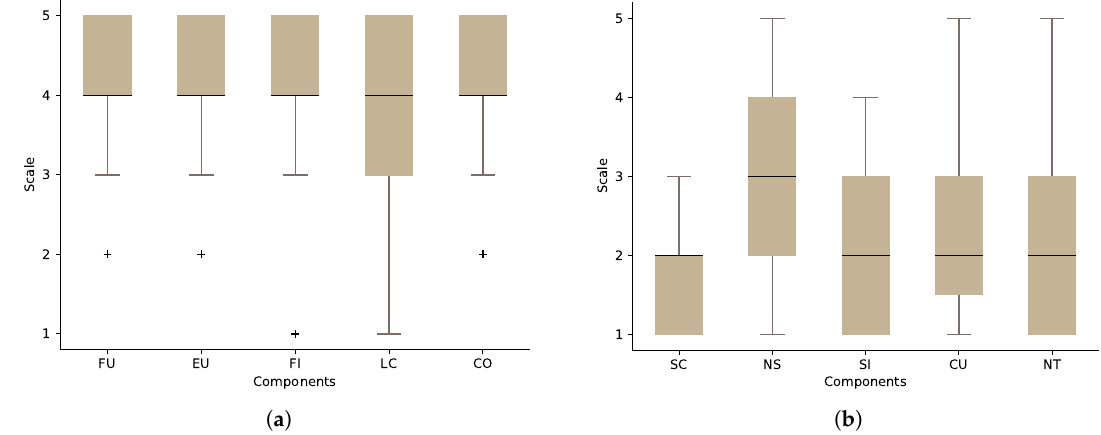
Figure 9. The result of System Usability Scale (SUS) questionnaire for the participants group. ( a ) The positive components; ( b ) the negative